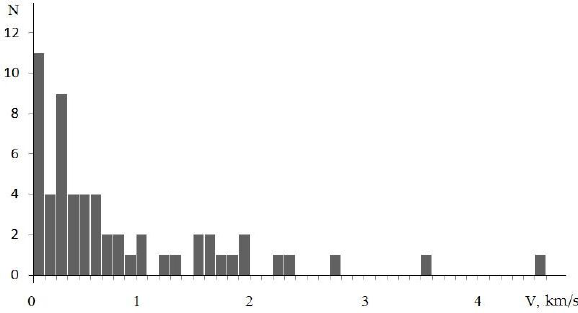
Figure 2. The distribution of the number N of comets in the velocity V of the ejection of particles of the anomalous